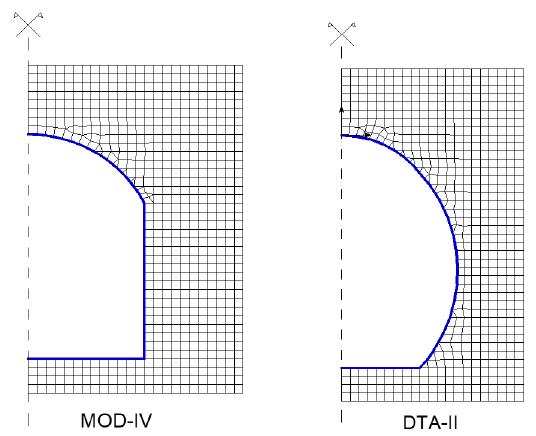
Figure 4. Finite element